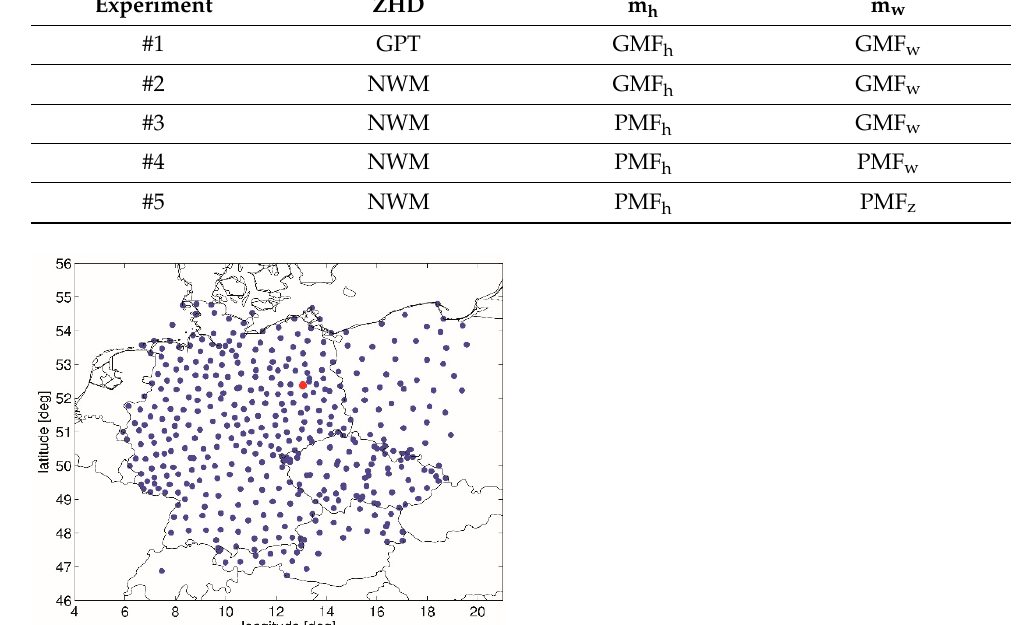
Table 1. Summary of the simulation experiments. The simulation experiments differed in the chosen ZHD, hydrostatic and wet MF. GMF stands for the global mapping function, GPT stands for the global pressure and temperature model, and PMF stands for the Potsdam mapping function, i.e., the MF calculated from the NWM. The subscripts h and w indicate hydrostatic and wet MF, respectively. The subscript z indicates modified wet MF. For details refer to the text.